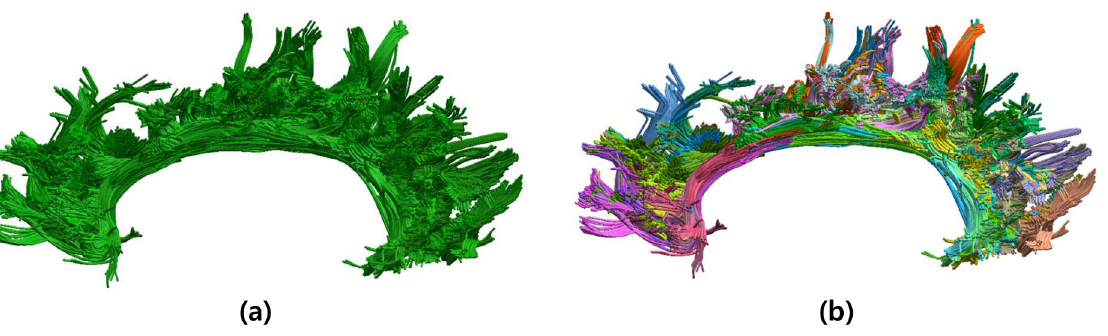
Fig 2. An anatomic bundle consists of tracts with various shapes. Cingulum bundle (a) contains many tracts with different shapes as shown in